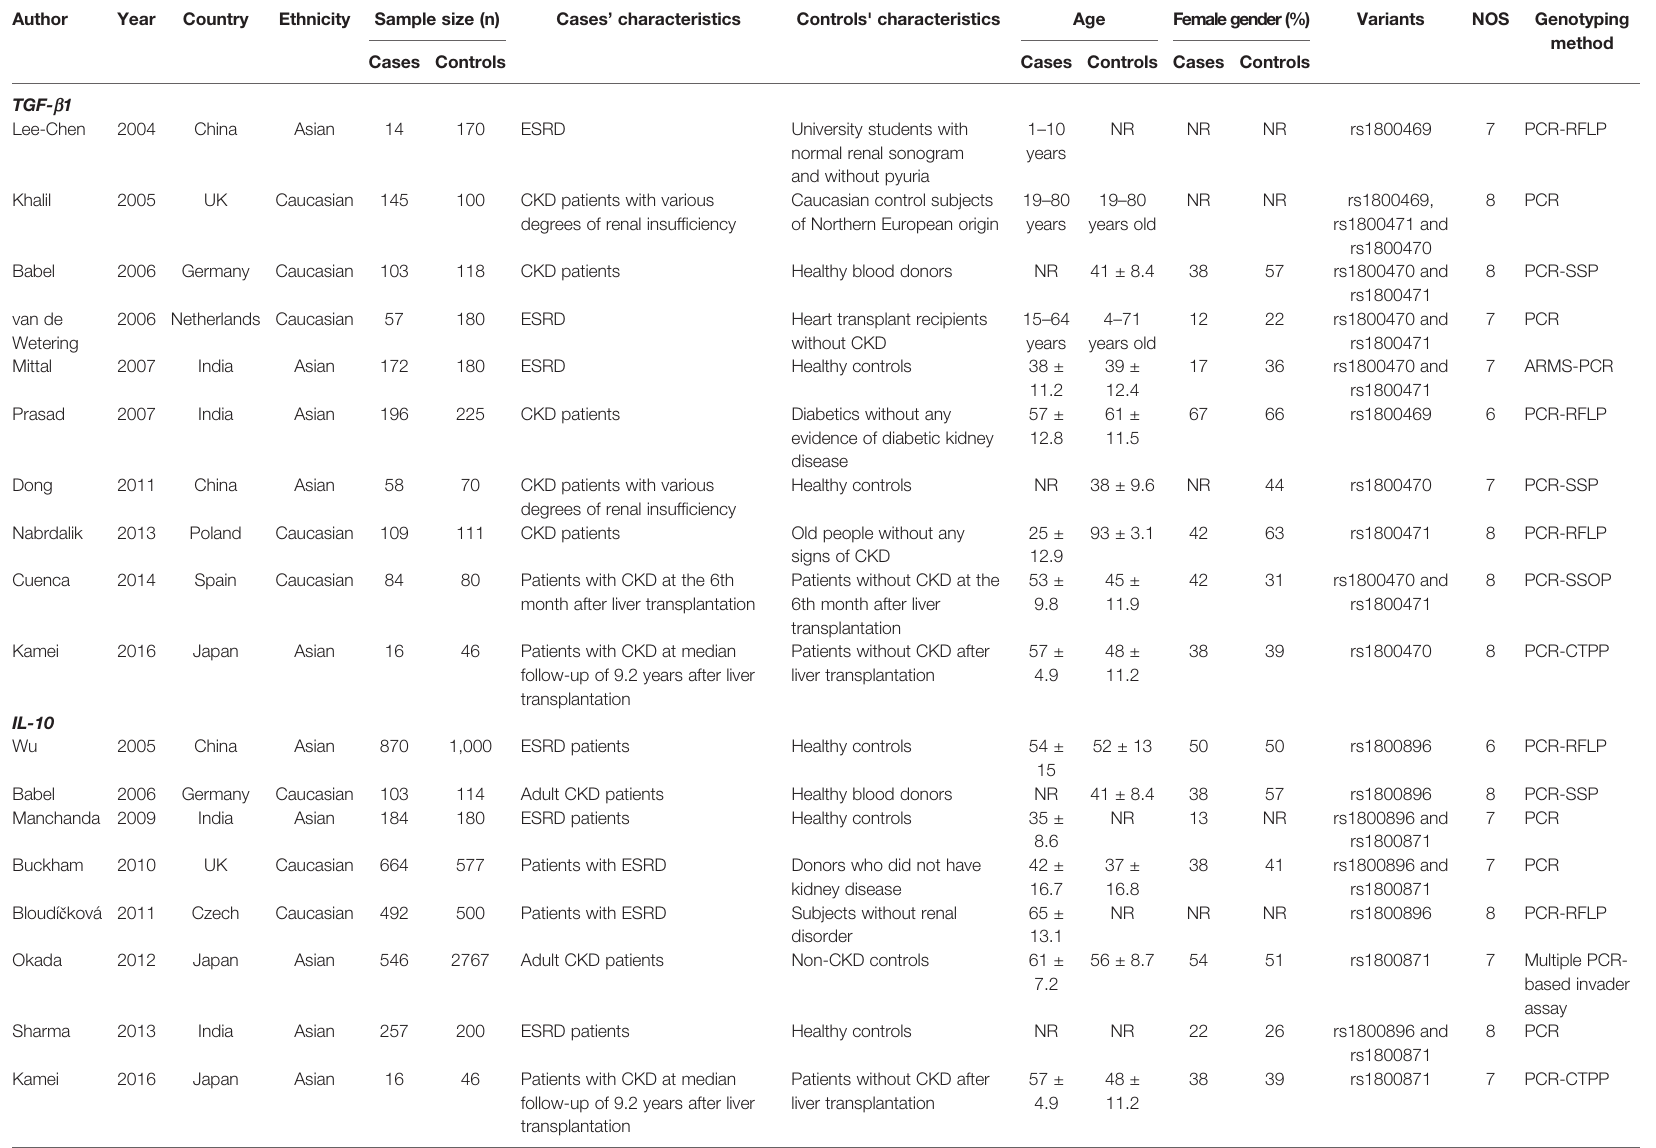
TABLE 1 | Characteristics of the included case-control